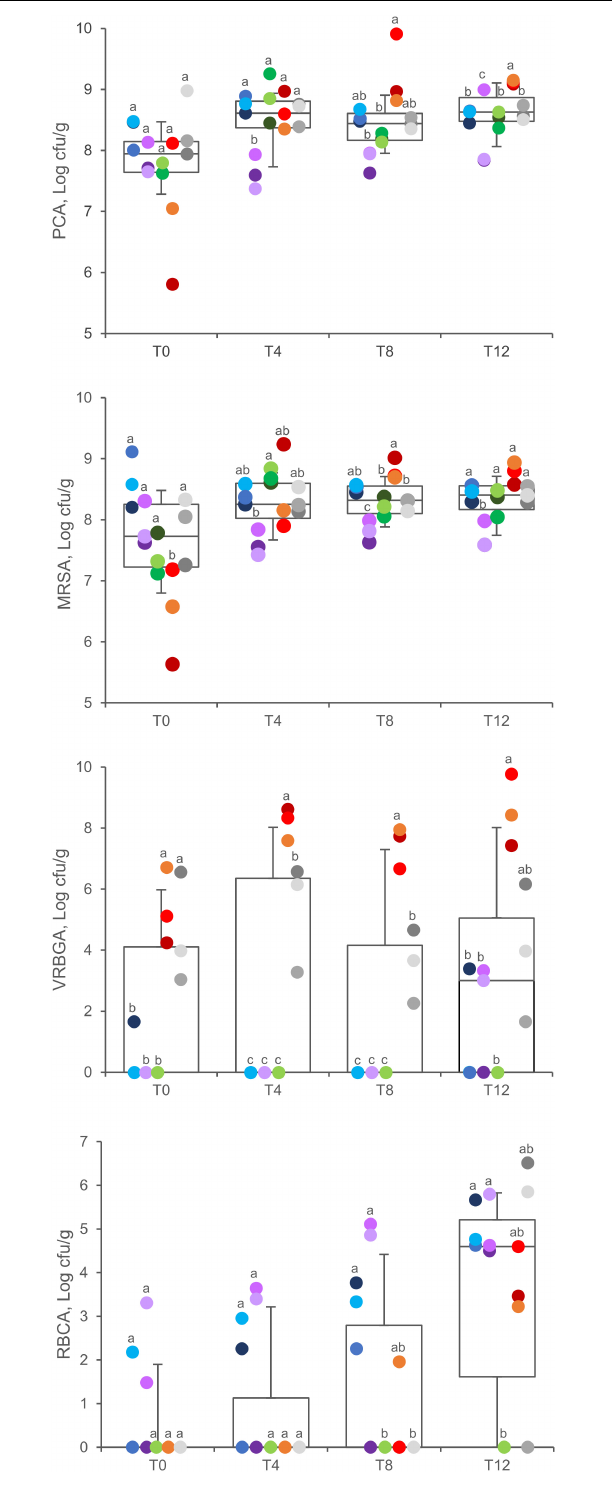
FIGURE 2 | Viable counts in PCA, MRSA, VRBGA, and RBCA plates of A (blue), B (violet), C (green), D (red), and E (gray) samples. Boxes indicate 25th, 50th, and 75th percentiles; whiskers indicate 10th and 90th percentiles. Within each time point, products sharing same letter did not make a significant difference ( p >